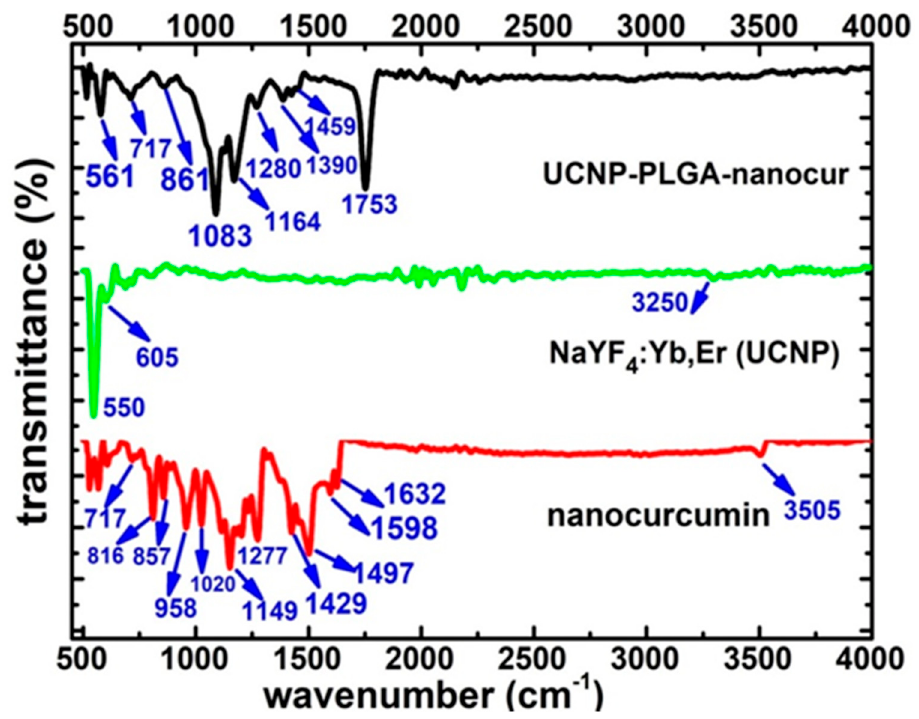
Figure 4. FTIR spectra of nanocurcumin, NaYF 4 :Yb,Er and UCNP-PLGA-nanocur. NaYF 4 :Yb,Er (UCNP) exhibits a strong absorption peak around 550 cm − 1 and